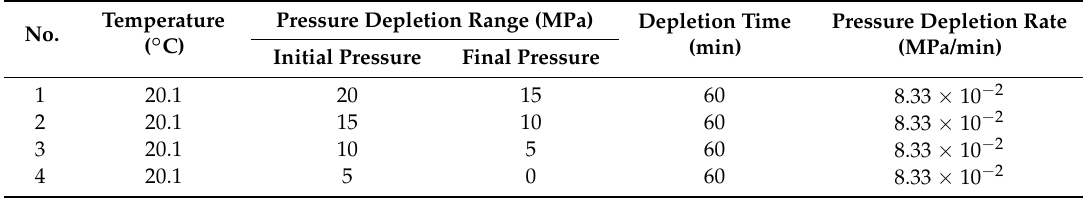
Table 4. Experimental conditions of step-like pressure